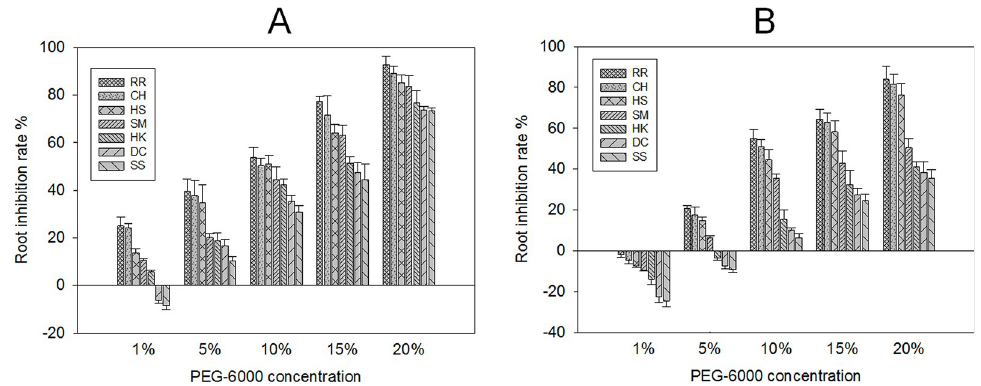
Fig 3. E . crusgalli root inhibition rate (%) under five PEG-6000 concentrations at different time periods. E . crusgalli root inhibition rate (%) under five PEG-6000 concentrations at 4 days (A) and 7 days (B) of treatment. Data are expressed as least square means ± standard